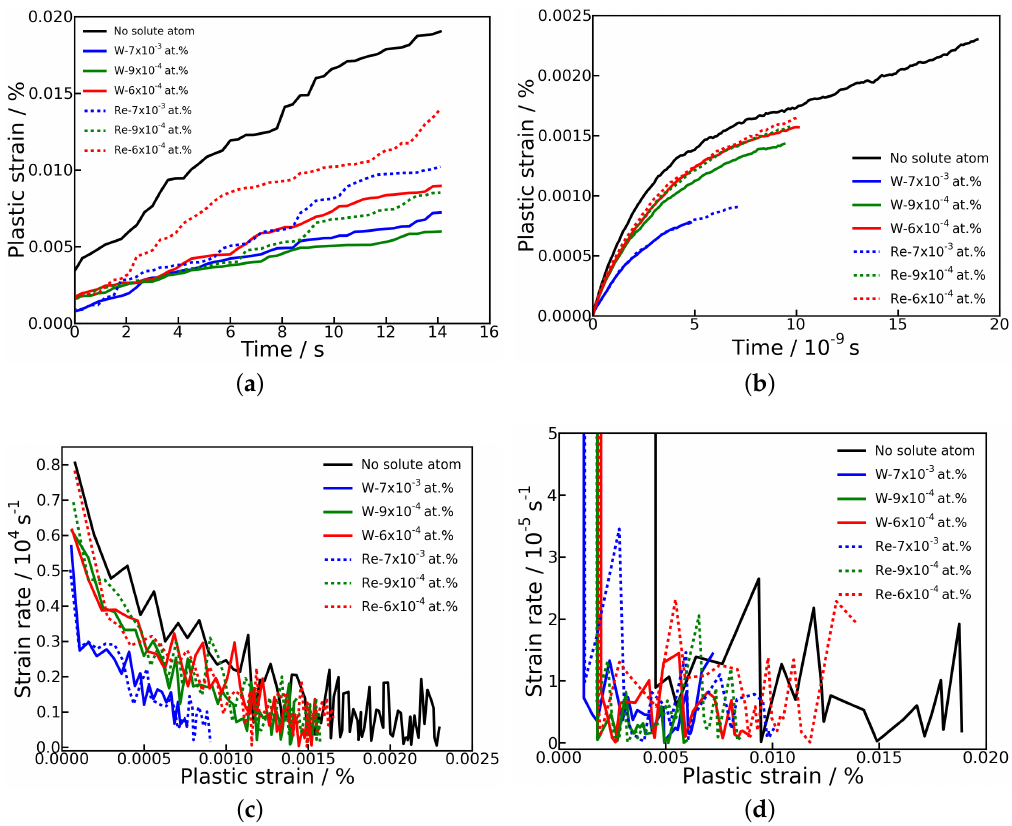
Figure 6. ( a ) Plastic strains as a function of time; ( b ) plastic strains in the primary stage of creep as a function of time; ( c ) strain rates in the primary stage of creep as a function of plastic strain; and ( d ) strain rates in the secondary stage of creep as a function of plastic strain for the addition of Re and W with different concentrations under 200 MPa tensile load along [001] direction at 850 ◦ C.